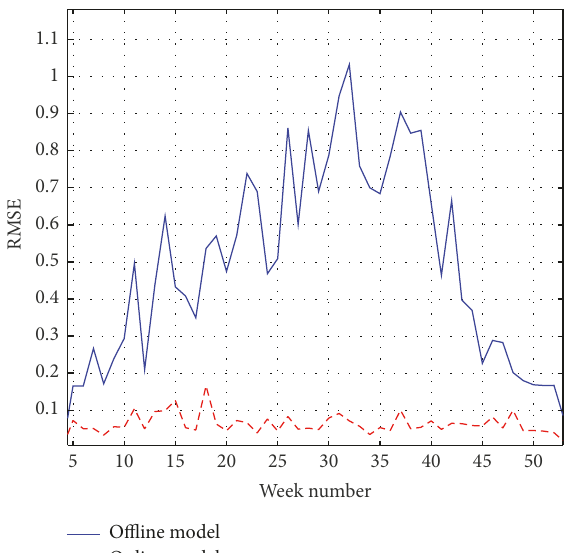
Figure 9: Error metric (RMSE) of the prediction of the zone air temperature for both the online and the offline learned SHS